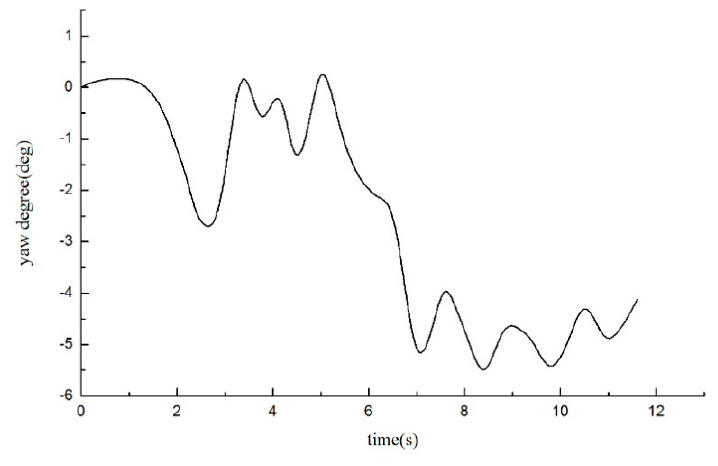
Figure 18. Yaw curve of the ship in case 7.